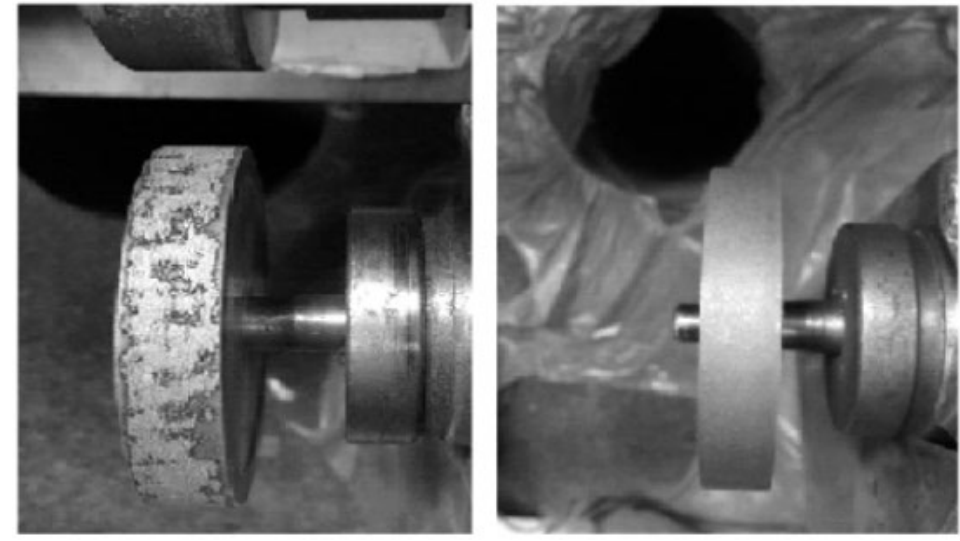
Figure 13. The surface condition of the grinding wheel after electric machining [44].